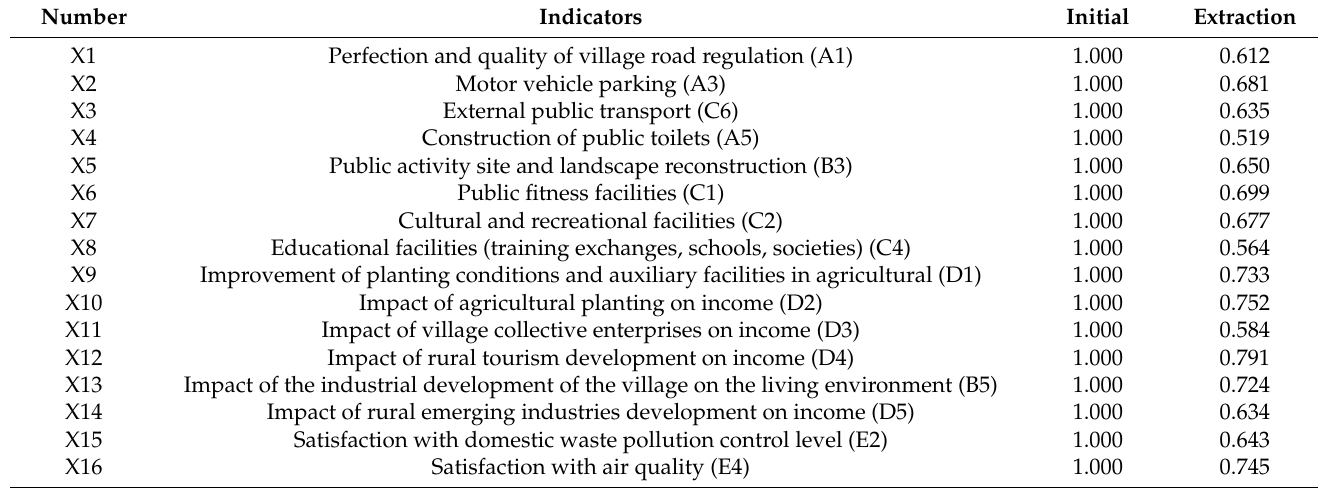
Table A1. Common factor variance ratio (number of variables = 16, number of valid questionnaires = 496).